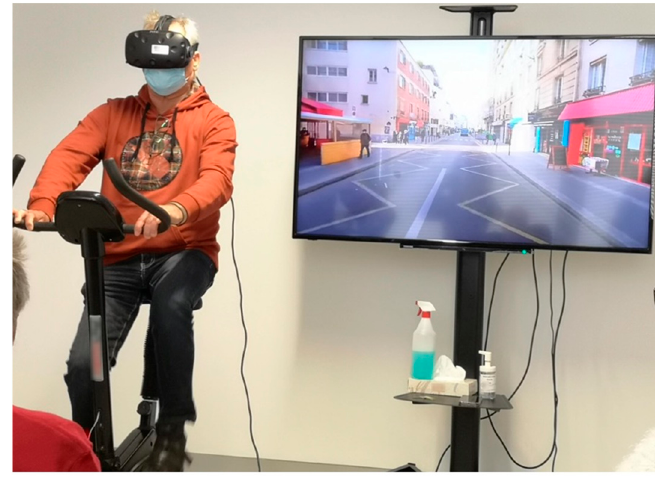
Figure 3. Participant testing the 360° VR cyclotourism experiment (phase two).